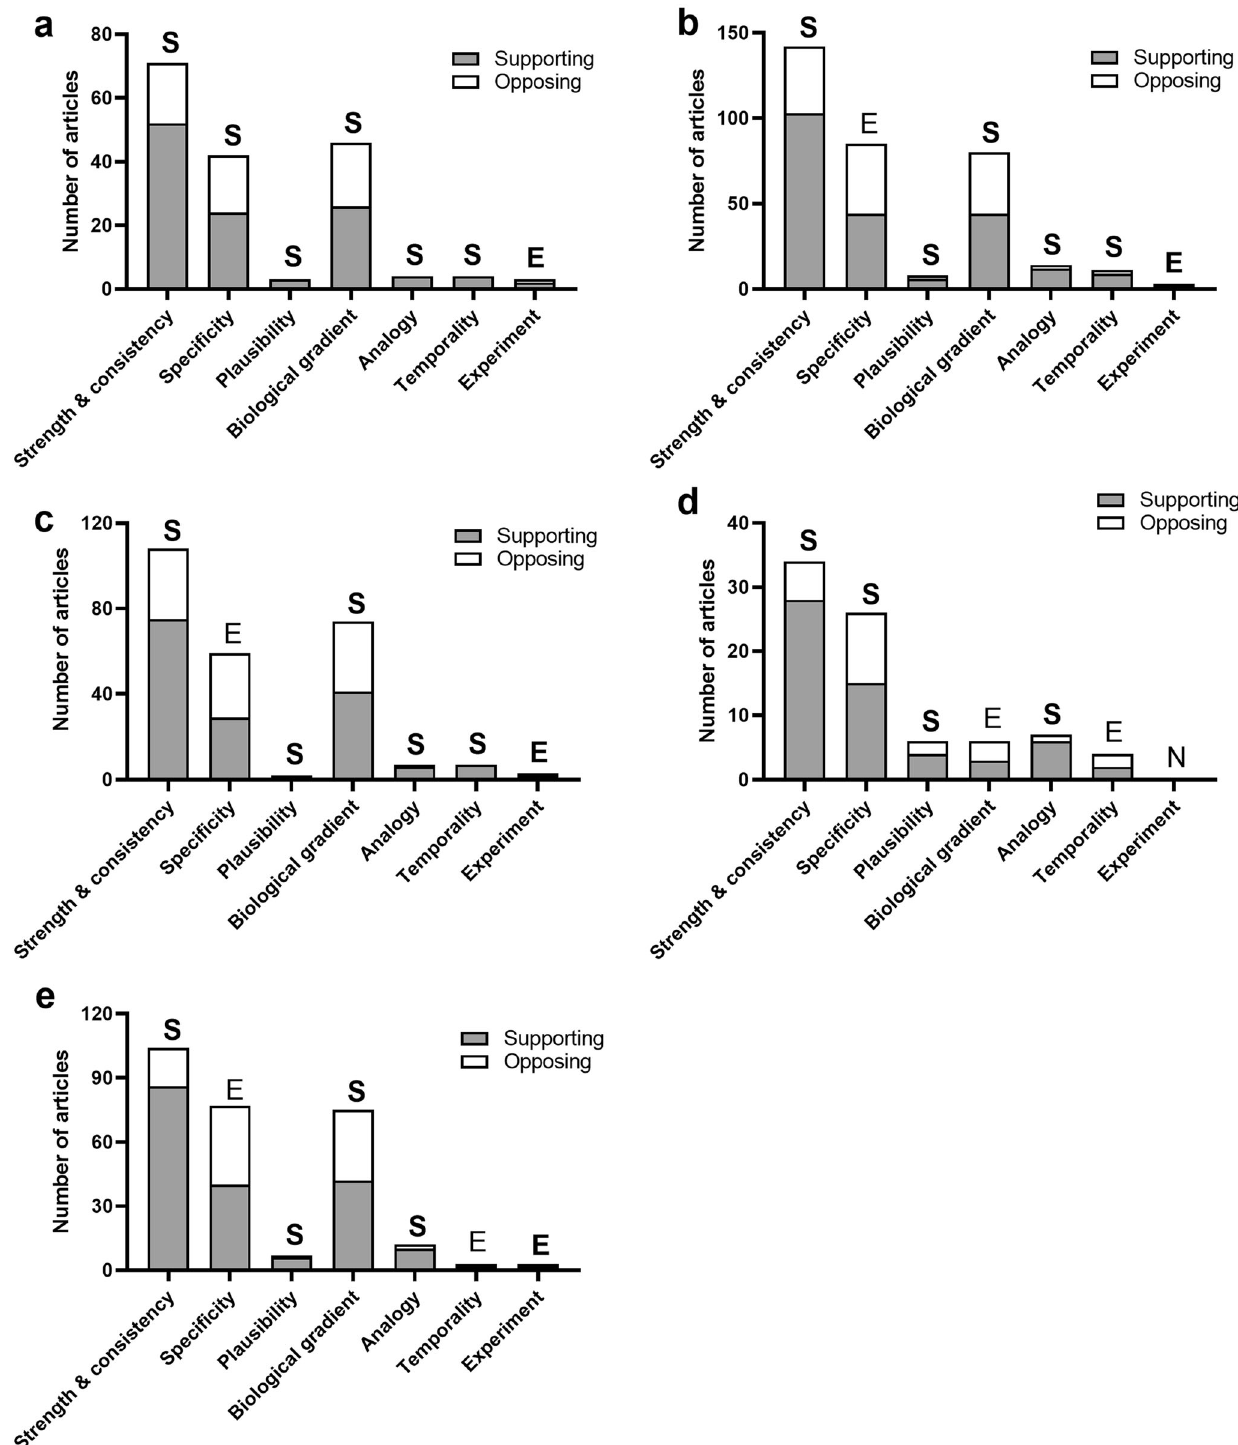
Fig. 2 Bradford Hill criteria data and outcomes of all included studies investigating alterations in SN iron levels, or levels of ferroproteins or iron-associated genes in Parkinson ’ s disease. a Portrays results obtained from high quality articles alone, whereas b depicts the combined results from high and moderate quality articles. c , d Data obtained from clinical or post-mortem studies respectively. e Data obtained from all articles reporting alterations in iron metal levels in the Parkinson ’ s disease SN or SNc, that is, excluding articles reporting protein and/or genetic changes. Data for the Bradford Hill criterion, coherence, is considerably higher than other criteria and was therefore presented in Supplementary Table 2. Letters S (supporting), O (opposing), and E (equivocal) indicate overall criteria outcomes determined by analyses of all included studies. Non-bolded letters highlight discrepant criteria outcomes between each panel and ( a ). N, no